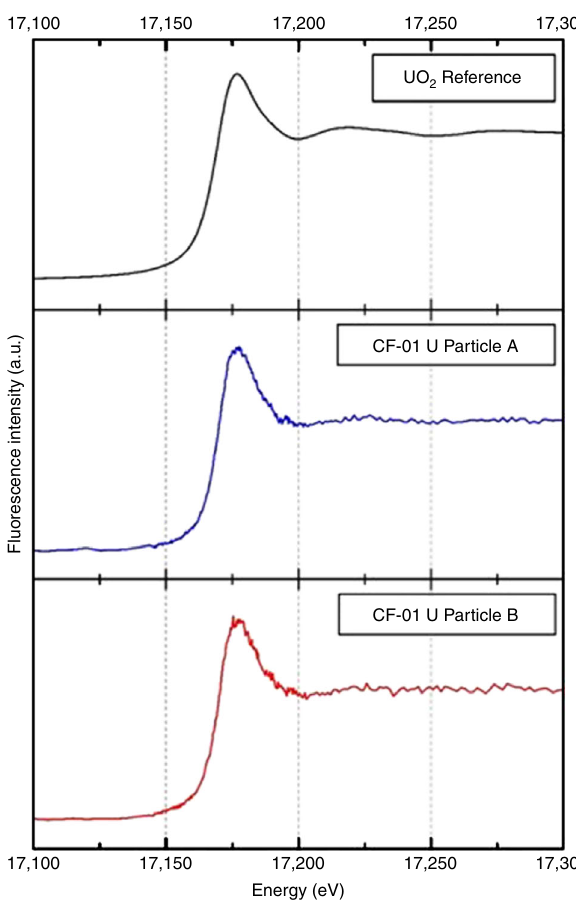
Fig. 2 X-ray absorption edge pro fi les: SR- μ -XANES fl uorescence intensity plots derived from two of the U composition particles contained within the sub-mm Si-based particle, alongside that of a comparison reference UO 2 spectra, from 44